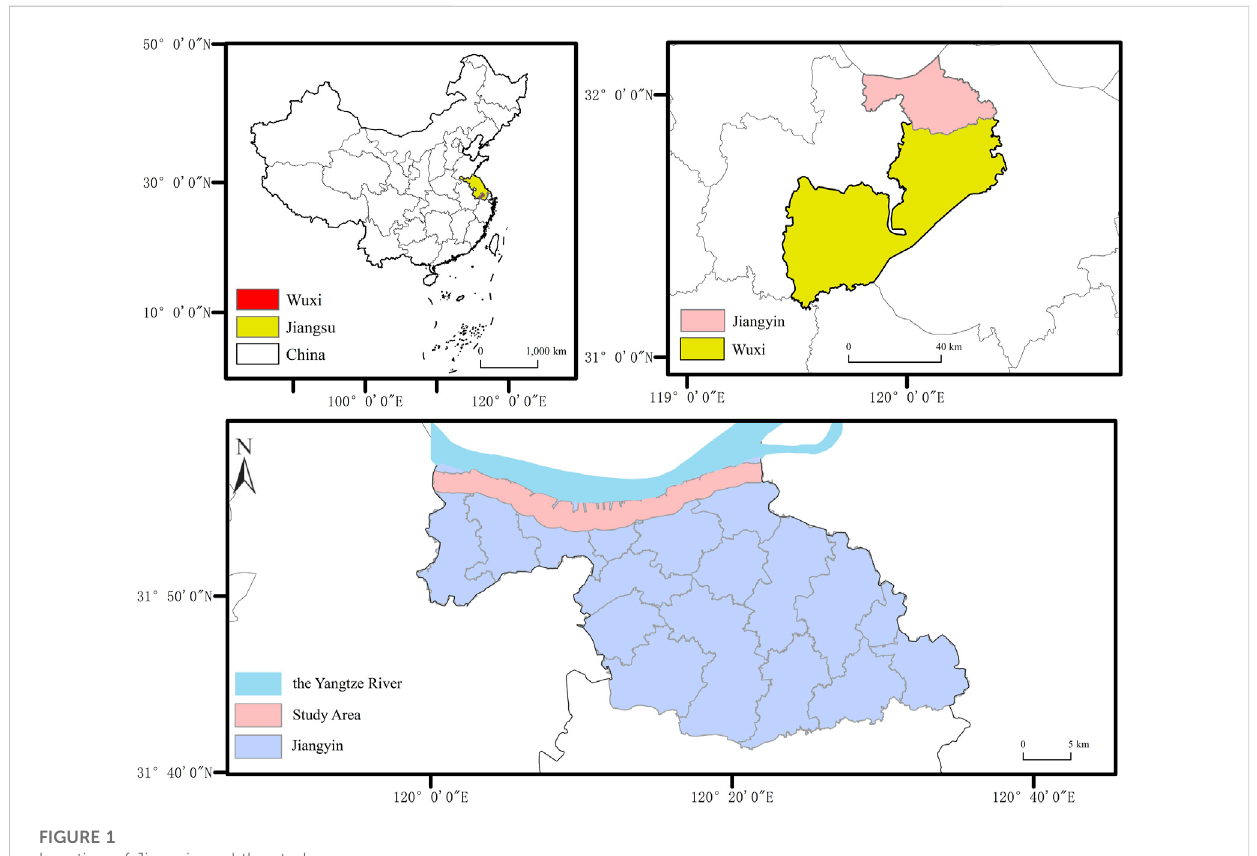
FIGURE 1 Location of Jiangyin and the study